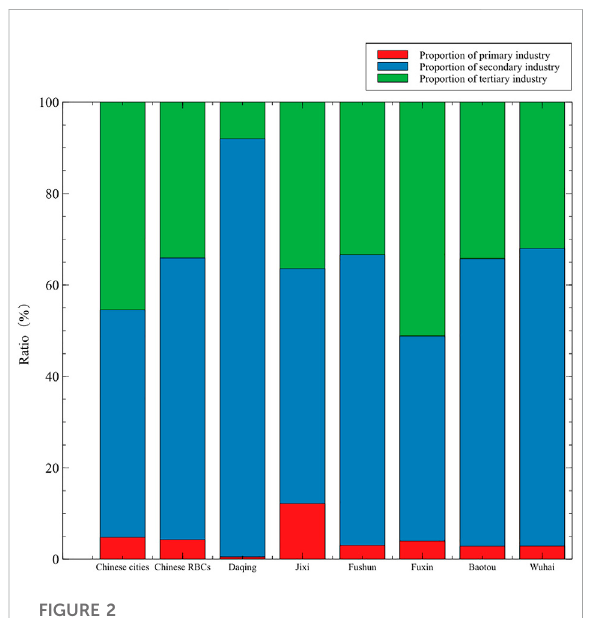
FIGURE 2 Industrial proportion of RBCs in northeast China in